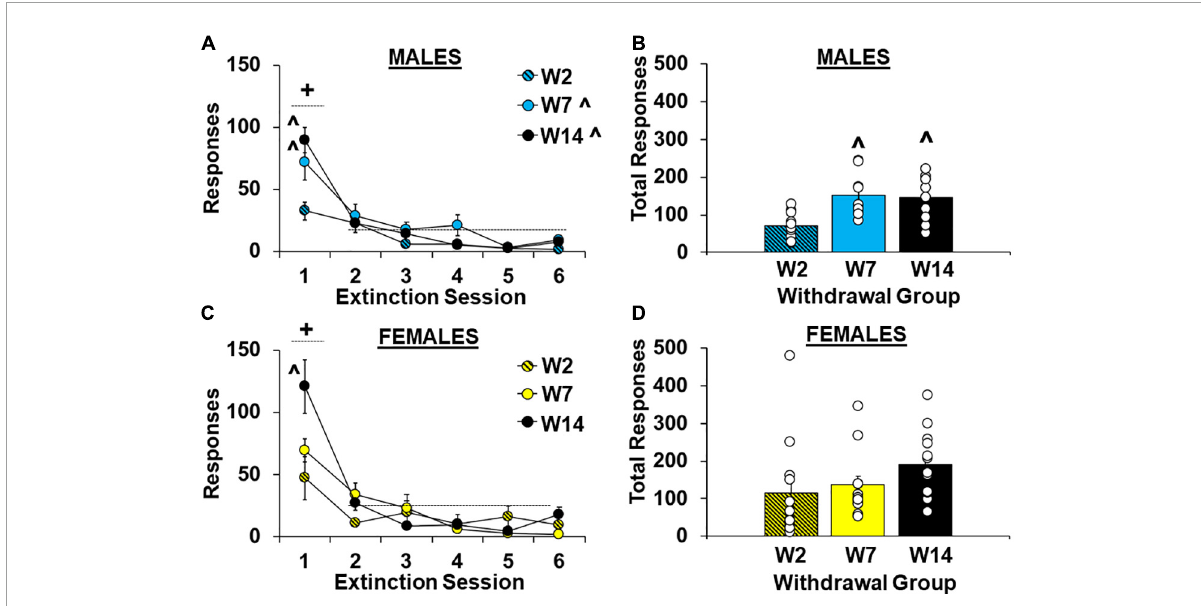
FIGURE3 Sex- and withdrawal-specific changes in extinction responding. Mean ( ± SEM) number of responses on the lever formerly associated with cocaine during the first six 1-h extinction sessions (A,C) and across all extinction sessions completed (B,D) for females (C,D) and males (A,B) in the early (W2; n = 13 females, 10 males), intermediate (W7; n = 13 females, 10 males), and late (W14; n = 13 females, 10 males) withdrawal groups. White circles indicate individual data points. + Significantly higher responding in the first extinction session versus later ones (averaged across sessions 2–6). ˆSignificantly higher than the early withdrawal group (overall and/or during the first extinction